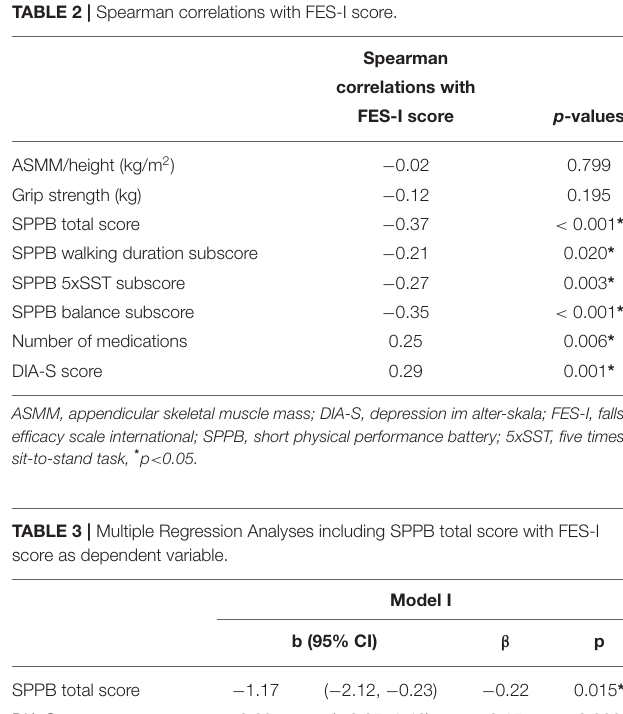
TABLE 2 | Spearman correlations with FES-I score.